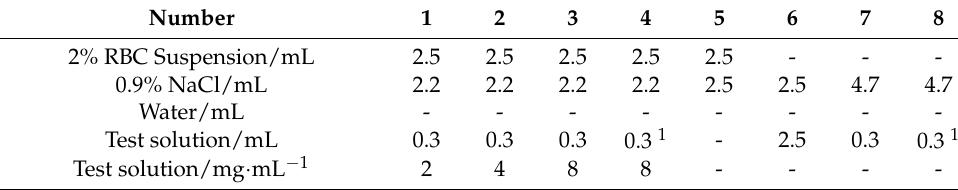
Table 2. Hemolysis experiment